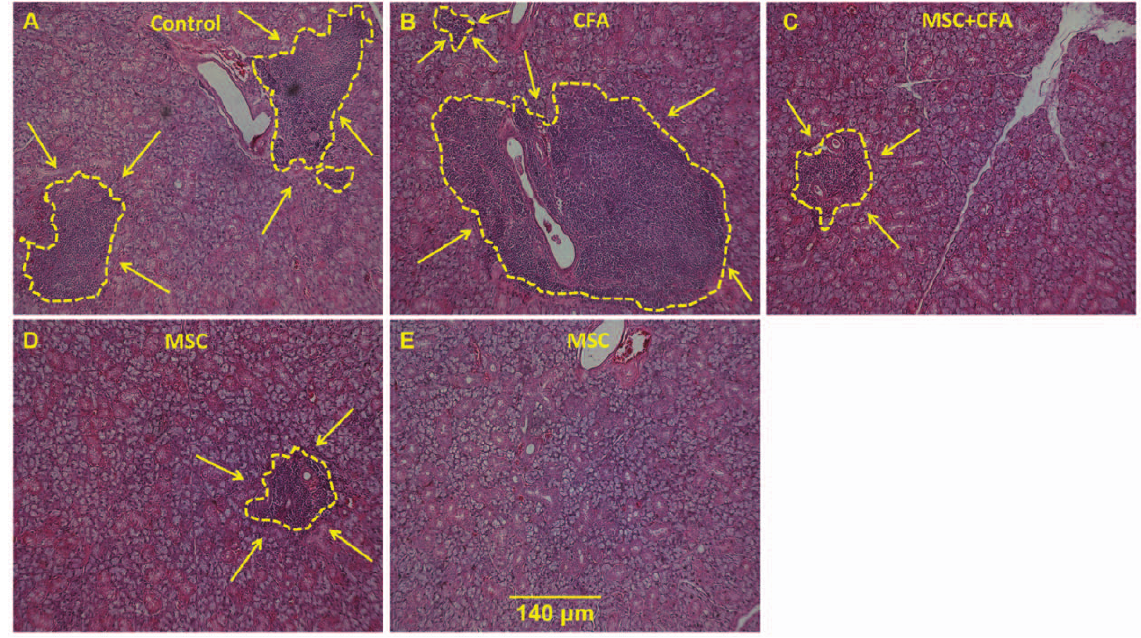
Figure 2. Infiltrate of lymphocytes in salivary glands of NOD mice. A–E: H&E staining showing size of the lymphocytic infiltrations (delineated with a yellow line and arrows) in NOD that were untreated (A), CFA-treated (B), MSC + CFA (C), MSC cells (D). In 2 of the 5 NOD mice transplanted with MSC only, no lymphocytic infiltrates were noted (E). Scale bar: 140 um for all images. F: Graph showing distribution of focus score (n=5 to 9 mice per group). The mean focus score was significantly higher in control (3.24) versus CFA (1.81), MSC (1.23), and MSC + CFA (1.8) NOD groups (* P =0.02).